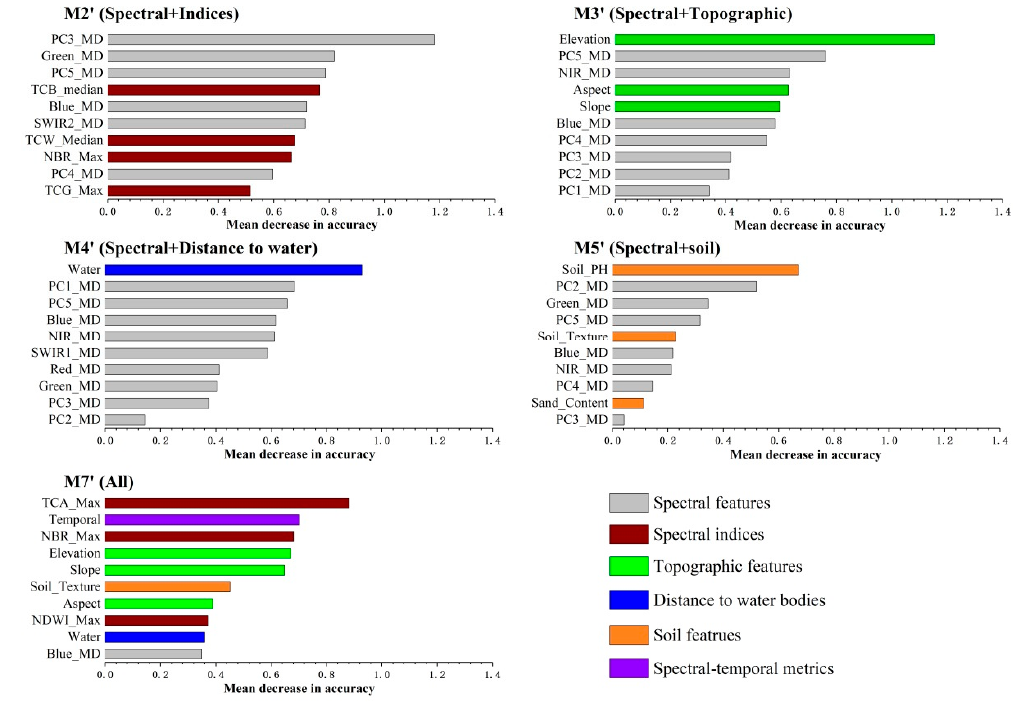
Figure 5. Most important features in the object-based models.